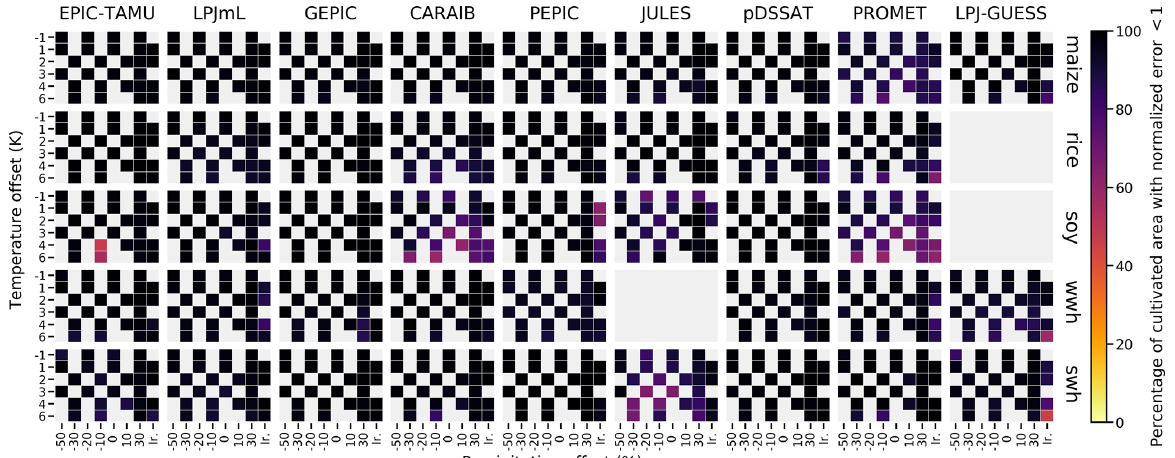
Figure 7. Assessment of emulator performance over currently cultivated areas based on normalized error (Eq. 5). We show performance of all nine models emulated, over all crops and all sampled T and W inputs (“ir.” indicates the irrigated W ∞ setting) but with CO 2 and nitrogen held fixed at baseline values. Large columns are crops, and large rows are models; squares within are T , W scenario pairs. Colors denote the fraction of currently cultivated hectares (“area frac”) for each crop with normalized area e less than 1 indicating the error between the emulation and simulation less than 1 standard deviation of the ensemble simulation spread. Of the possible 63 scenarios at a single CO 2 and N value, we consider only those for which all nine (eight for rice, soybean, and winter wheat) models submitted data (Fig. S1) so the model ensemble standard deviation can be calculated uniformly in each case. JULES did not simulate winter wheat and LPJ-GUESS did not simulate rice and soybean. Emulator performance is generally satisfactory, with some exceptions. Emulator failures (significant areas of poor performance) occur for individual model–crop combinations, with performance generally degrading for colder and wetter